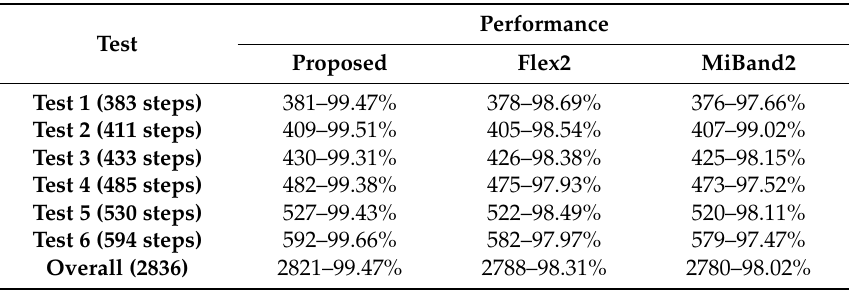
Table 4. Performance evaluation in comparison to Flex2 and